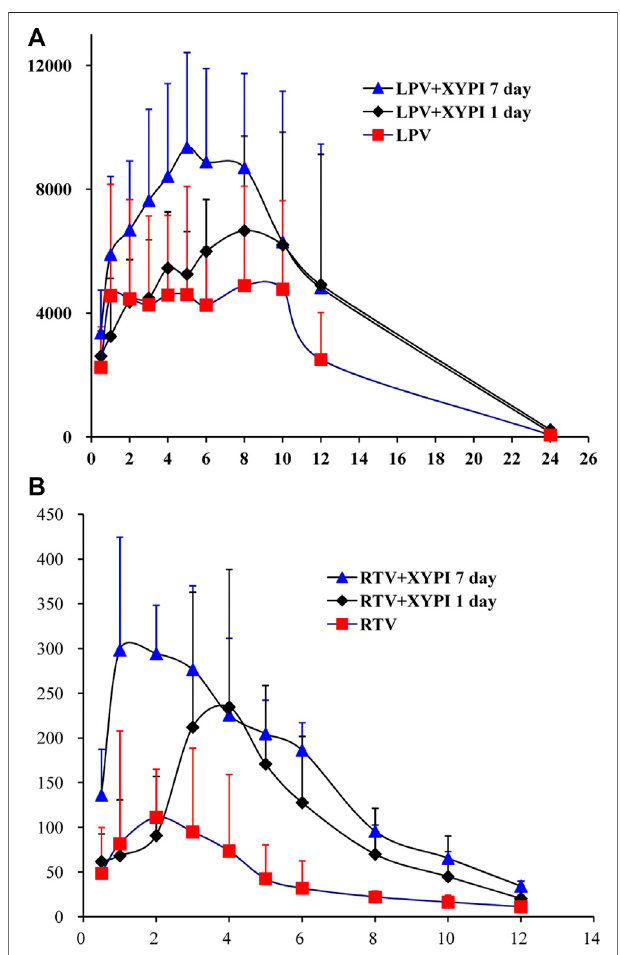
FIGURE 2 | Mean plasma concentration-time pro fi les of LPV (A) and RTV (B) following oral administration of LPV/RTV (42:10.5 mg/kg) in rats that were pretreated with or without XYPI (x ± SD, n (cid:1) 6).